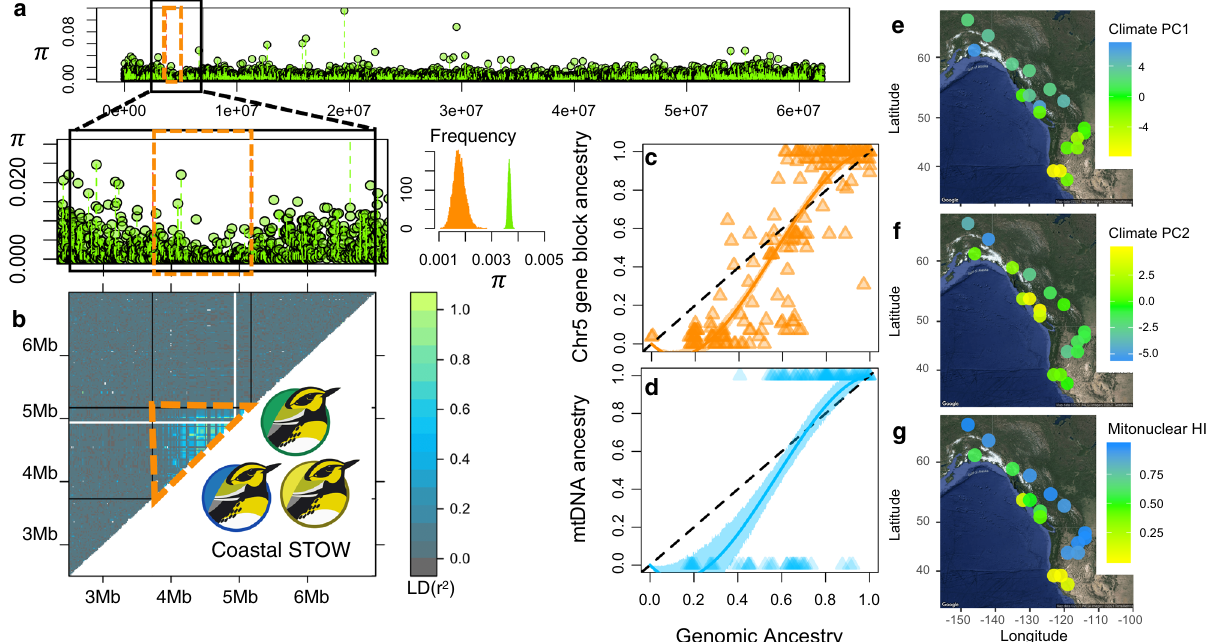
Fig. 5 Signature of selection in mitonuclear ancestry is associated with climatic variation. a There is lower nucleotide diversity ( π ) in the candidate gene block compared to the rest of chr5. The histogram illustrates the bootstrap distribution of mean π of the candidate gene block (orange) versus the rest of chr5 (green). b LD ( r 2 ) was signi fi cantly higher in the candidate gene block (orange box) than its surrounding region between 2.5 and 7 Mb on chr5. Bird illustrations by Gil Jorge Barros Henriques. c – d Genomic clines of chr5 candidate gene block ( c ) and mtDNA ( d ), re fl ecting signatures of divergent selection as well as SOCC-biased introgression. Color shades represent the 95% con fi dence intervals of the genomic clines. e – f Spatial distributions of climate PC1 and PC2. g Site mean mitonuclear ancestry (averaged ancestry of mtDNA and chr5 candidate gene block) is correlated with local climate PC1 (partial mantel test, r = 0.30, p = 0.0108), as well as PC2 (partial mantel test, r = 0.20, p = 0.0464). e – g Map data ©2019